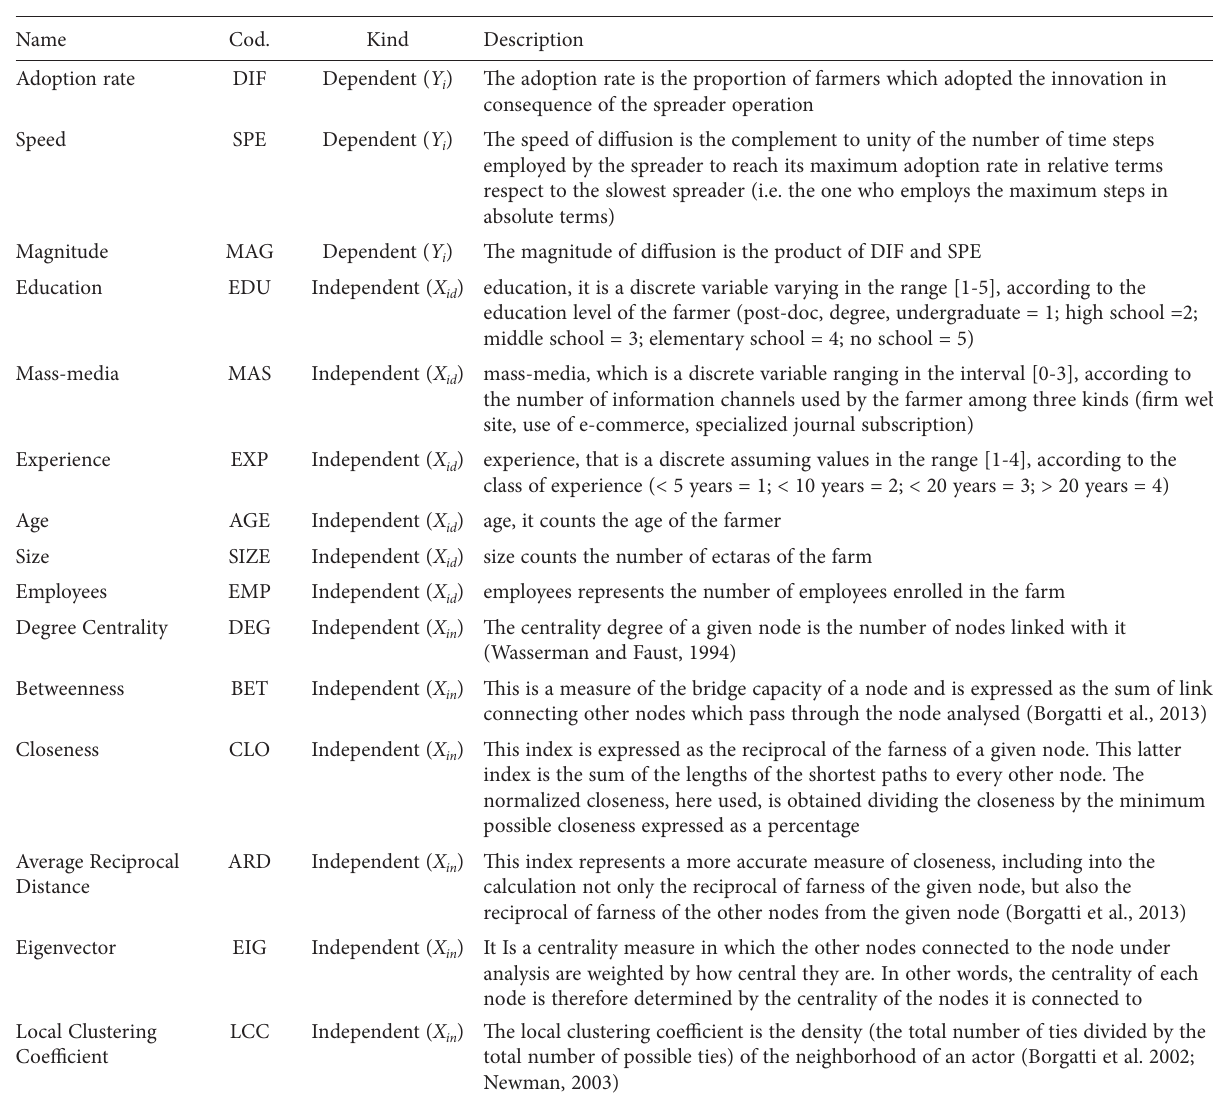
Table 1. The variables of the model. Name